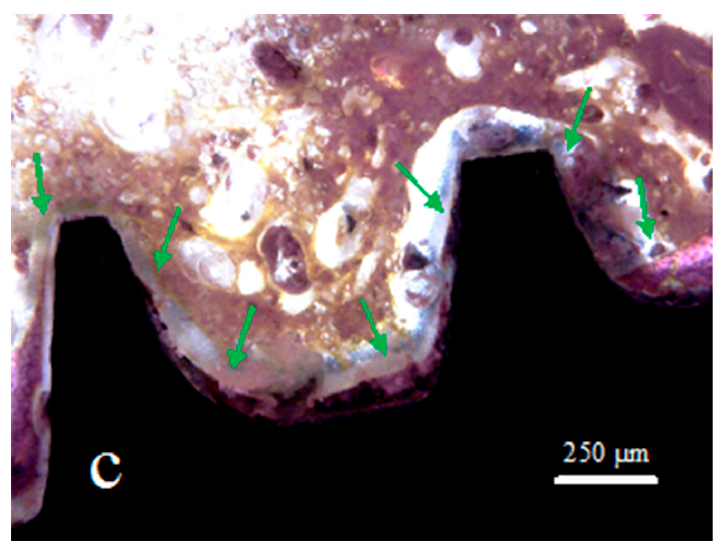
Figure 6. Representative histological images of samples: ( a ) Group 1, ( b ) Group 2, and ( c ) Group 3. The green arrows indicate the areas with new bone formation inside of the implant threads. In the side that was in contact with the portion of the cortical bone (side 1), the implants of all